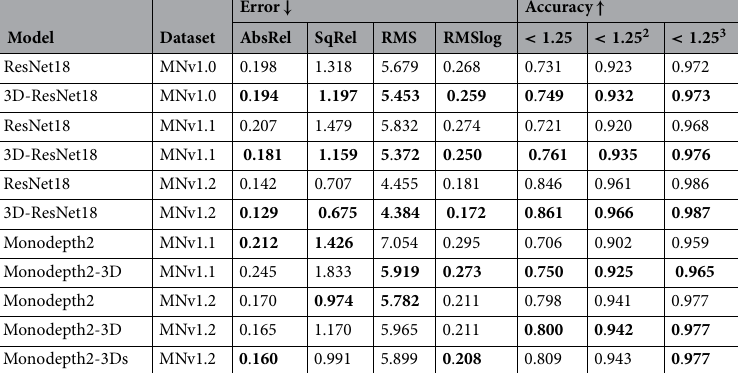
Table 2. Quantitative results in MN datasets. First six model are trained in supervised and the rest are unsupervised (monodepth2). The best results in each dataset are shown in